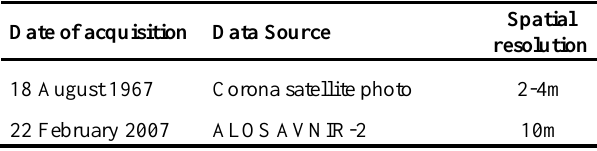
Table 1. Remotely sensed dataset.